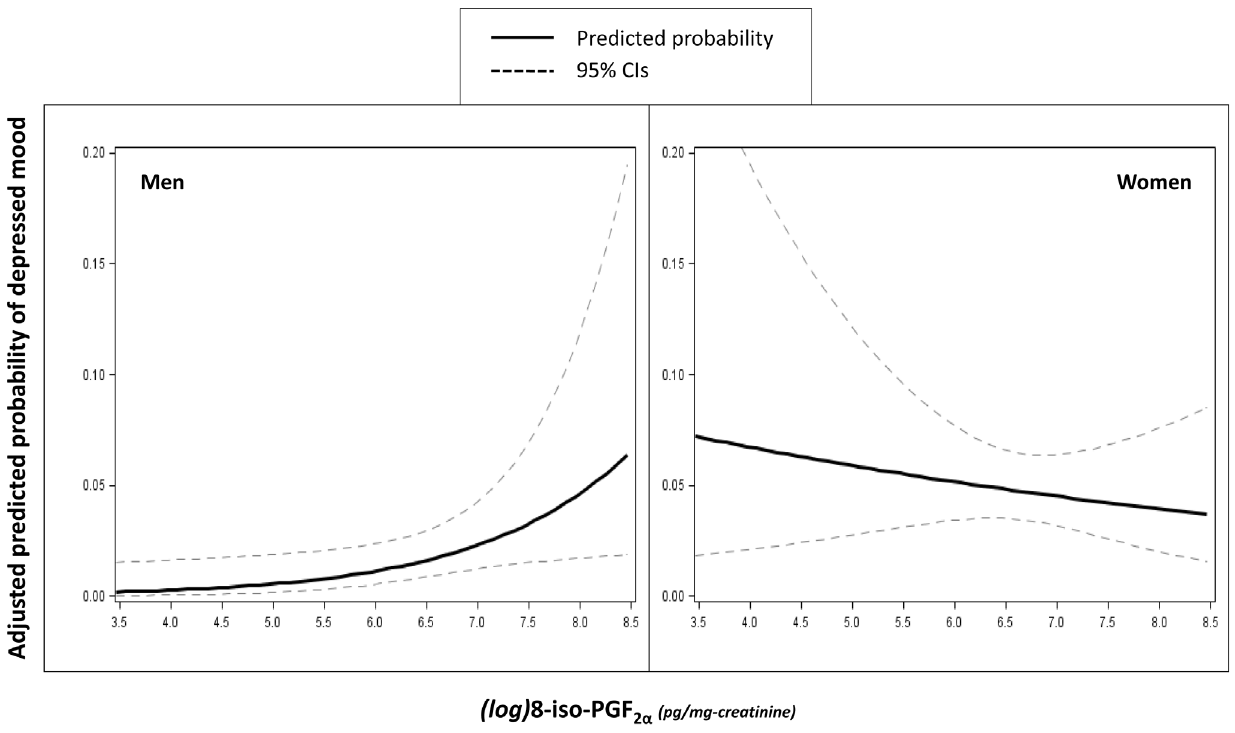
Figure 2. Plot of (log)8-iso-PGF 2 a concentrations versus adjusted predicted probability of depressed mood according to sex. Predicted probability and 95% Confidence Intervals (95%CIs) are adjusted for age, race, education, site, alcohol use, smoking, 3MSE, physical activity, BMI, cerebrovascular disease, CVD and diabetes.